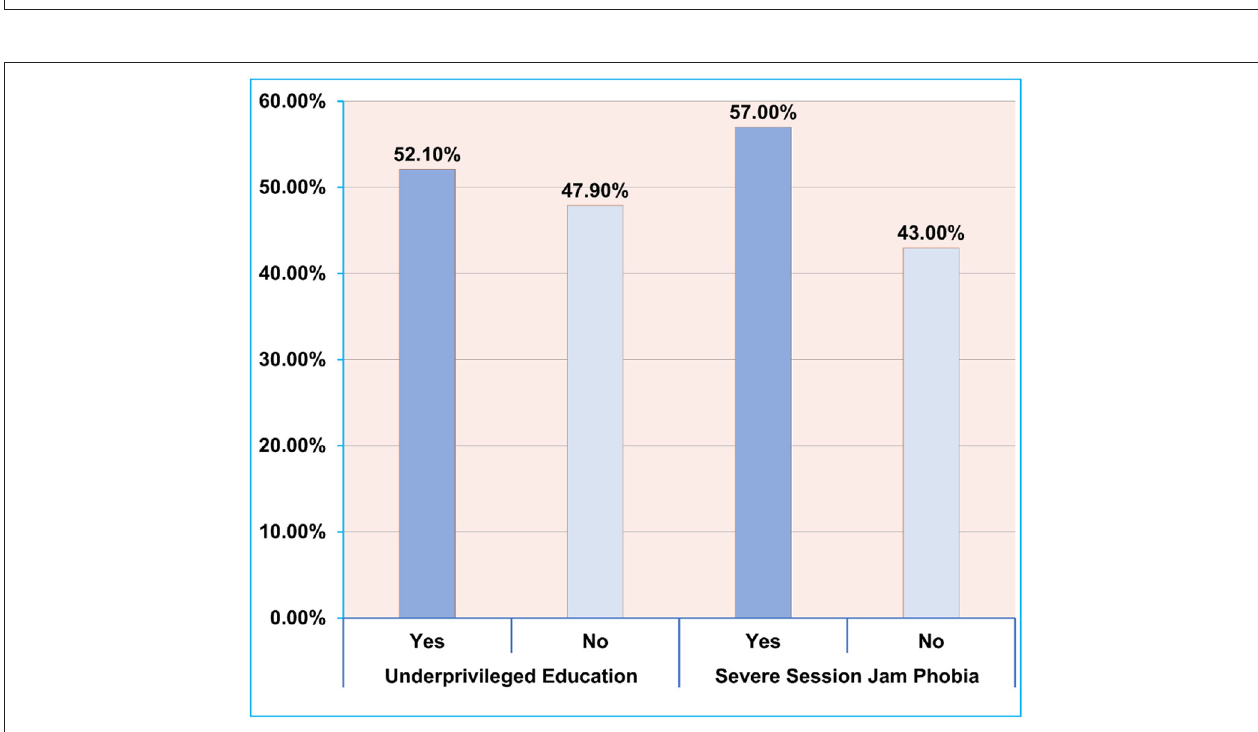
FIGURE 3 | Prevalence of underprivileged online education and extreme session jam phobia (SJP) among university students following the prolonged countrywide shutdown in Bangladesh.